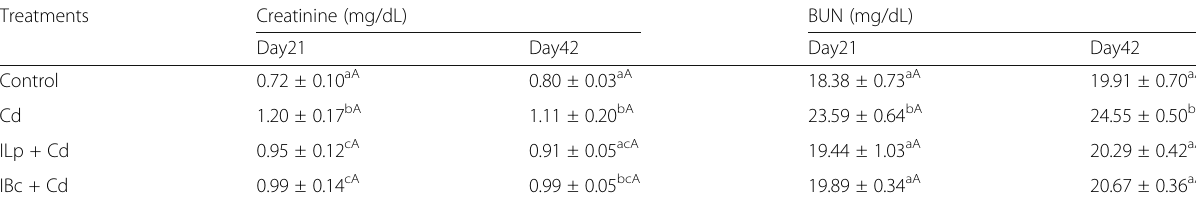
Table 3 Effects of oral administration of cadmium on levels of BUN and creatinine of rats fed synbiotic diets containing inulin, B. coagulans and L. plantarum at days 21 and 42 of treatments Treatments